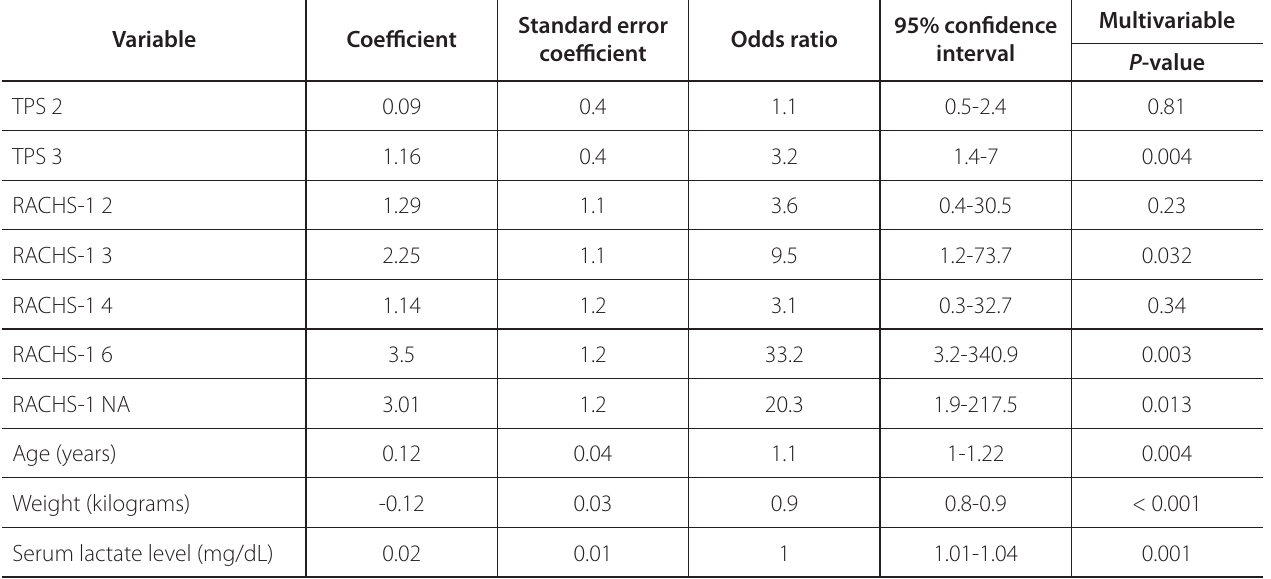
Table 4 . Mortality risk factors — multivariable analysis.